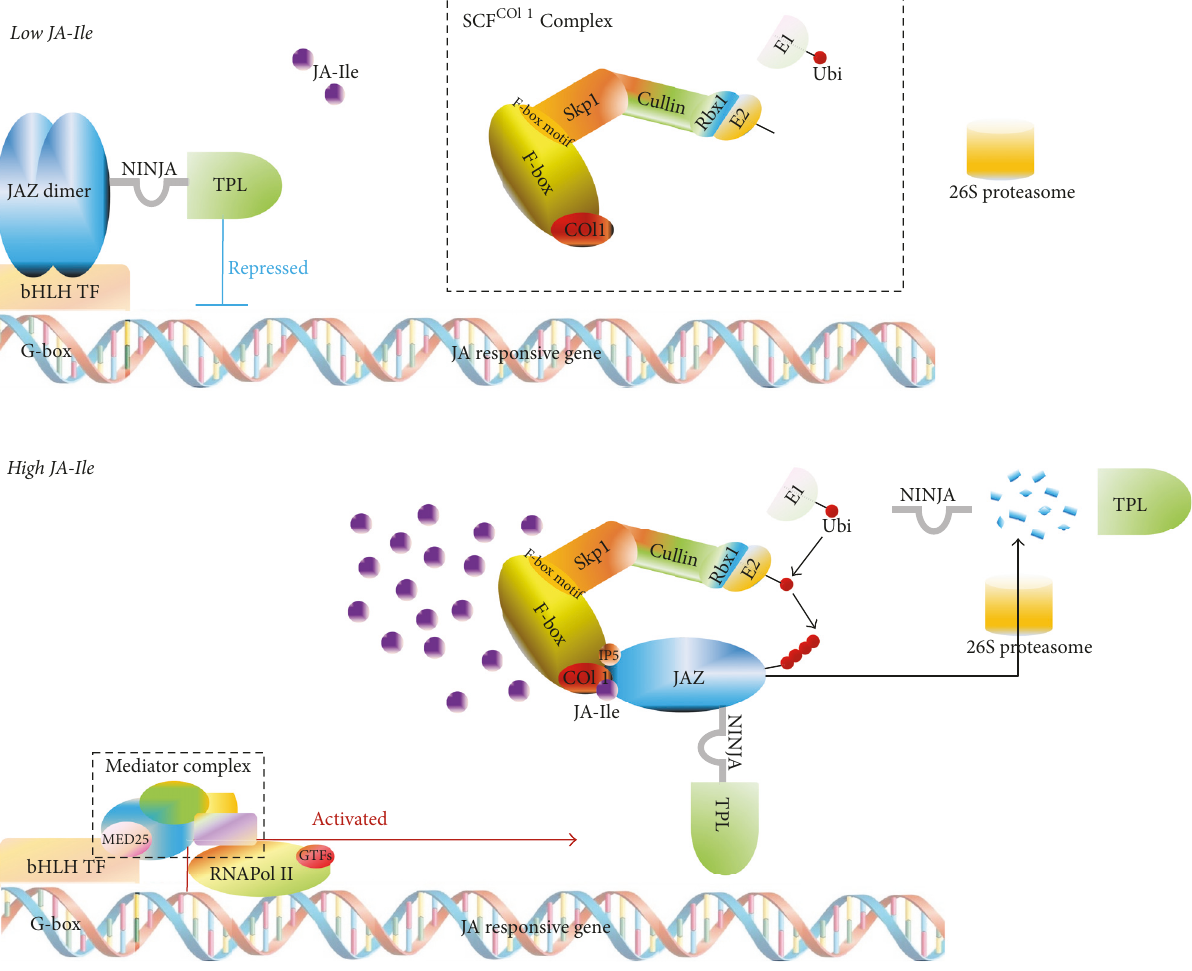
Figure 3: Signal transduction of jasmonates (JAs) [58,